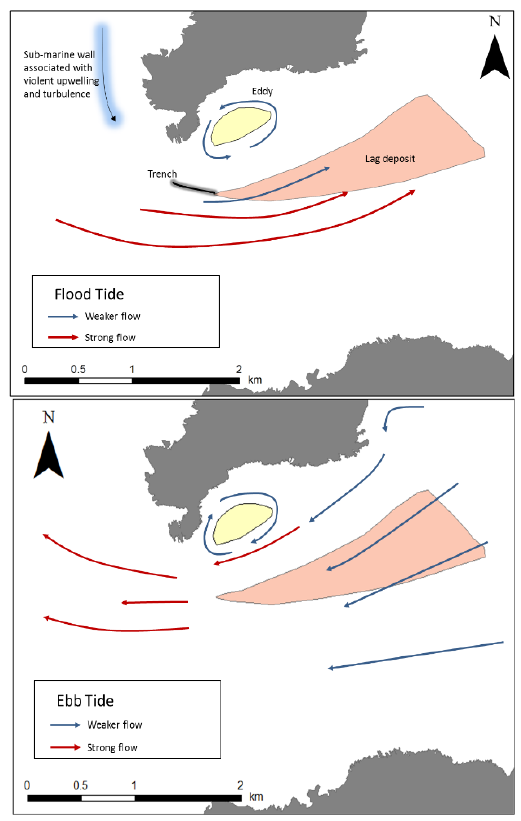
Figure 12. Inferred sediment dynamics during flood ( top ) and ebb ( bottom ) tides. The yellow oval bank is medium grained sand whilst the pink wedge shaped bank is carbonate shell.